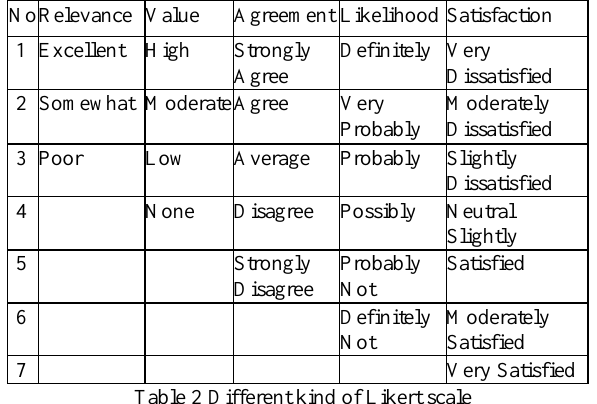
Table 2 Different kind of Likert scale